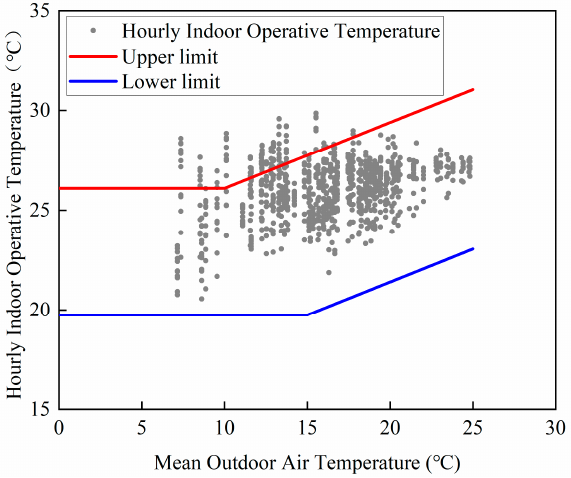
Figure 15. Adaptive comfort data for the natural ventilation mode.